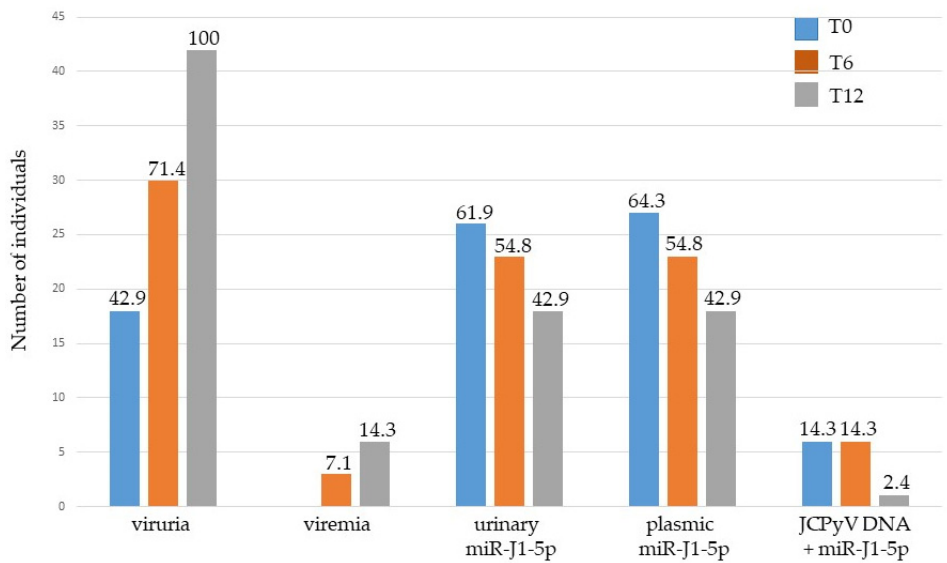
Figure 2. Combined assessment of JCPyV DNA detection, serostatus and miRNA expression in 42 subjects with MS. T0: before starting treatments, no drug administration; T6: 6 months after the beginning of therapy; T12: 12 months after the beginning of therapy. The number on top of each bar represents the percentage of persons with MS who had viruria, viremia, urinary or plasmic miR-J1-5p or concomitant JCPyV DNA and miR-J1-5p detection,